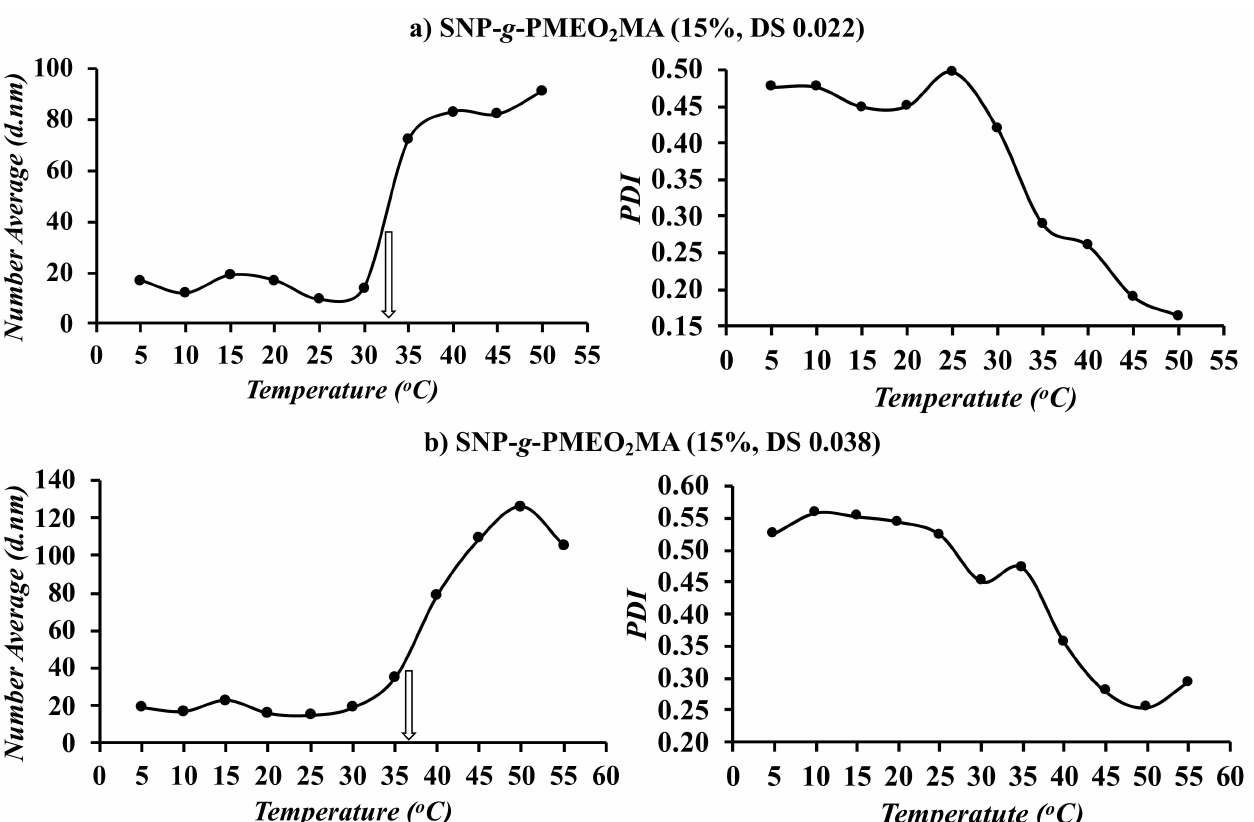
Figure 5. Temperature-dependent variations in size and polydispersity of SNP- g -PMEO 2 MA (15%) at DS ( a ) 0.022 and ( b )